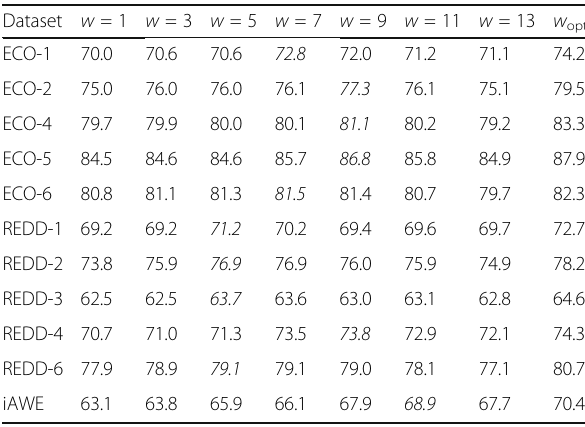
Table 4 Energy disaggregation performance in terms of estimation accuracy ( E ACC ) for different temporal contextual window lengths